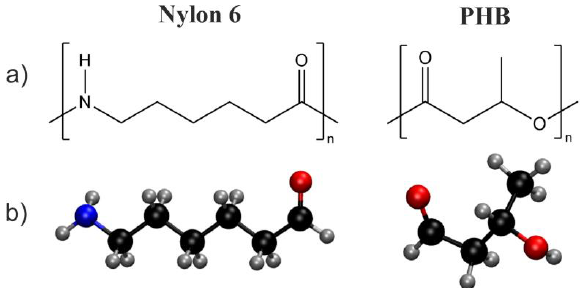
Figure 1. Structure of nylon 6 and polyhydroxybutyrate polymers: ( a ) structural formula of the polymer, ( b ) chemical structure of polymer monomer; the colors of the spheres are as follows: black—carbon, light grey—hydrogen, red—oxygen, blue—nitrogen.